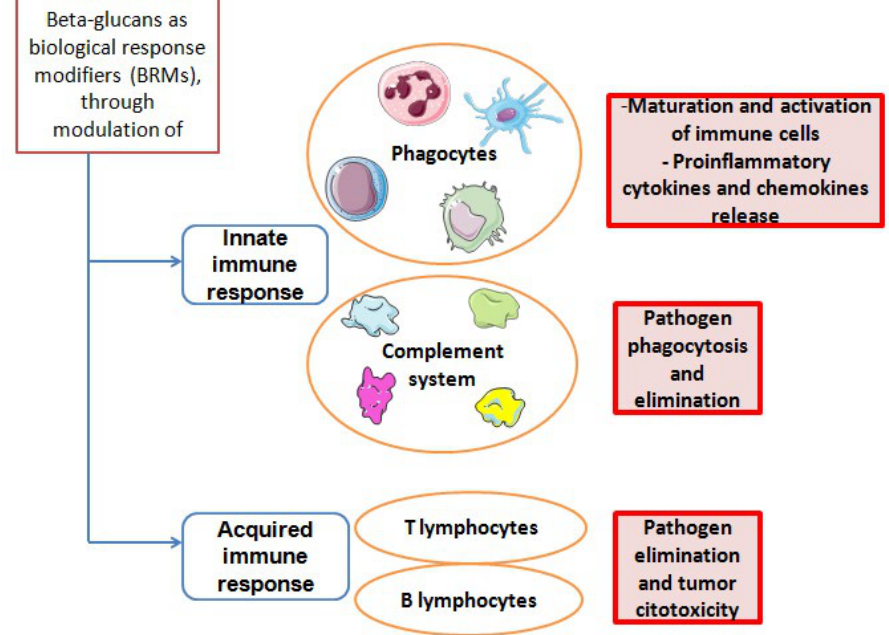
Figure 1. Interaction pathways between β-glucans and the immune